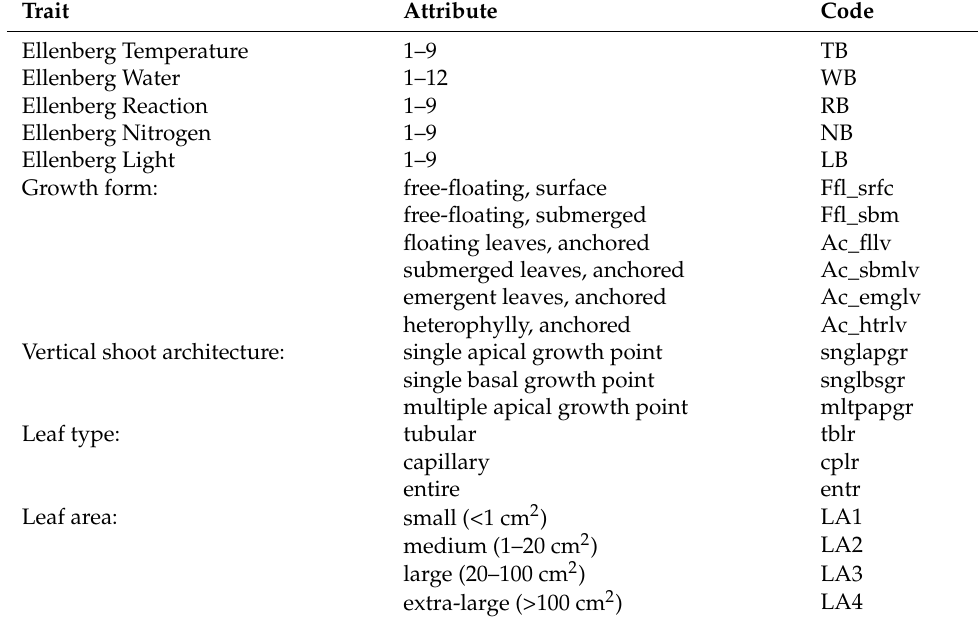
Table 2. List of 14 plant species traits and their attributes included in the